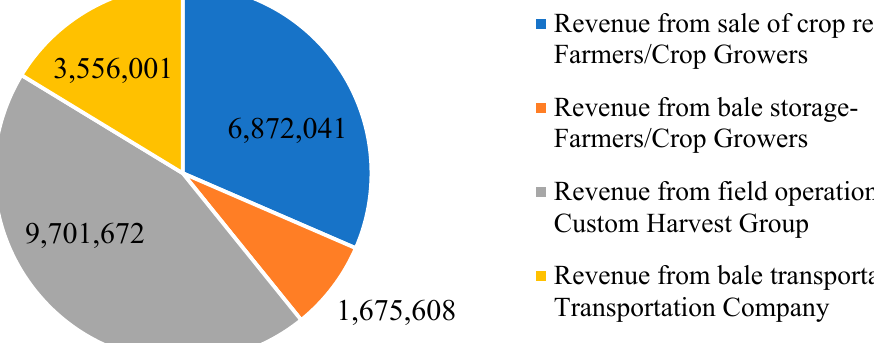
Figure 9. Contribution of different biomass logistics operations to the total annual generated incomes in all six case studies (in Canadian dollars).